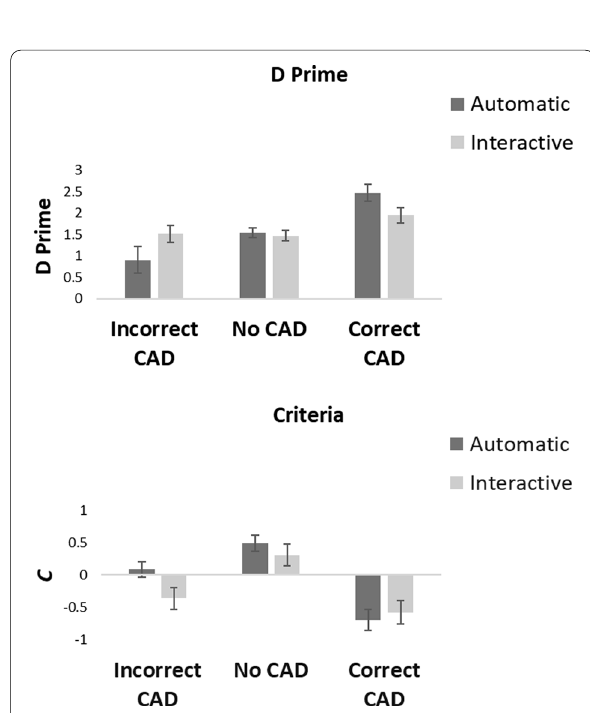
Fig. 3 D ′ and c values for the automatic and interactive conditions in Experiment